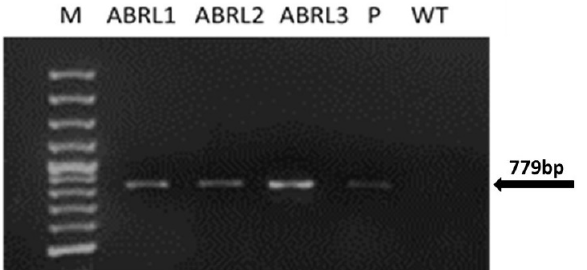
Figure 1. PCR amplification with rolB specific primers. Lane M represents 100 bp DNA marker (Fermentas); ABRL1-3 are transgenic lines of A . bracteosa ; WT stands for wild-type tissue cultured plants; P corresponds to plasmid DNA.